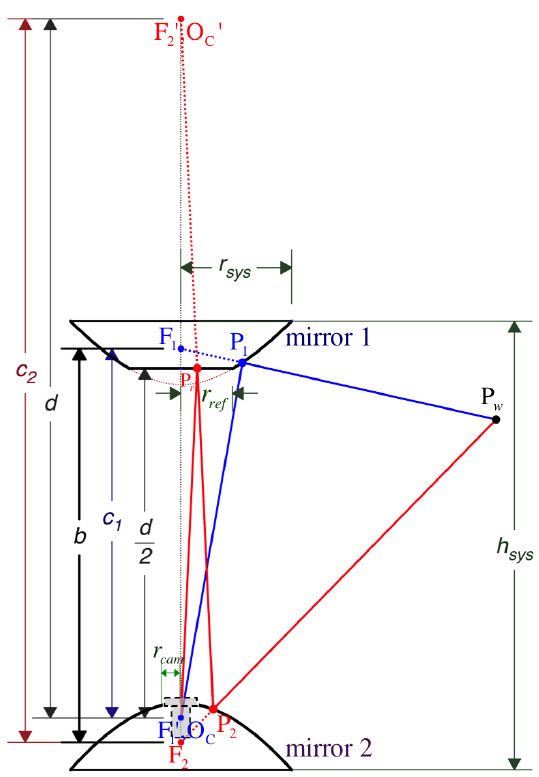
Figure 3. Geometric model and observable design